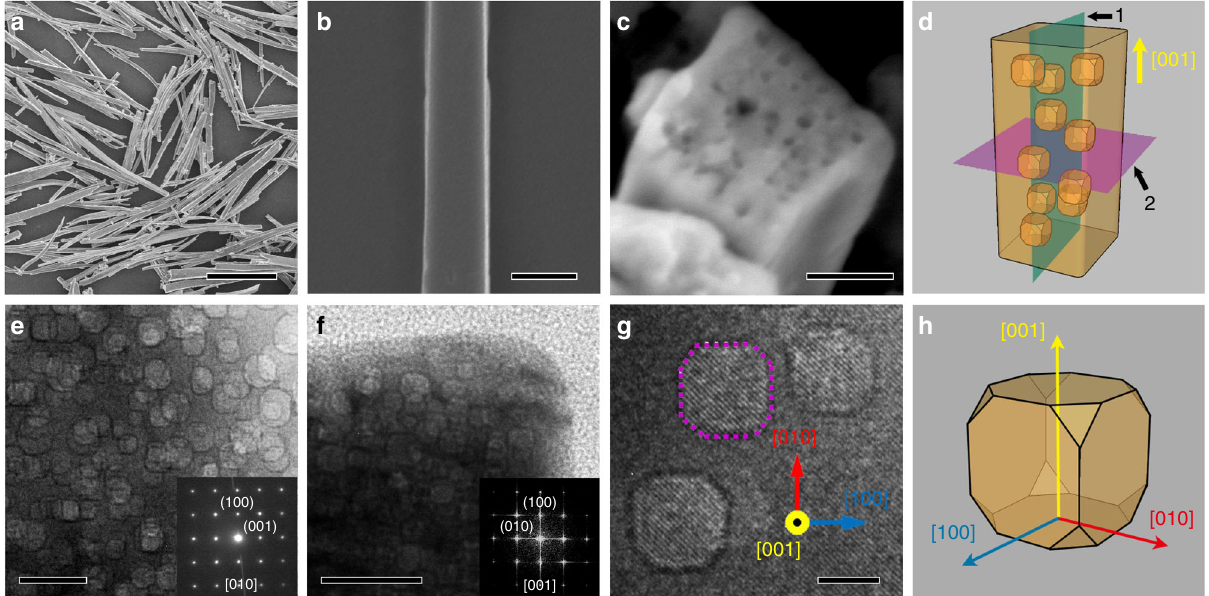
Fig. 1 Morphology and microstructure characterization of the mesoporous PTO fi bers. a SEM image of mesoporous PTO fi bers. Scale bar, 10 μ m. b SEM image (scale bar, 500 nm) and c cross-section SEM (scale bar, 100 nm) image from top view of a single fi ber. d Schematic illustration of a mesoporous PTO fi ber with many mesopores involved. e , f cross-section TEM images of mesoporous PTO fi ber along radial (the blue face in d , marked as 1, scale bar, 20 nm) and axial (the purple face in d , marked as 2, scale bar, 50 nm) direction, respectively. The insets display the corresponding SAED image and FFT pattern. g Cross-section TEM image of several typical mesopores. Scale bar, 5 nm. h Truncated cube model of a single